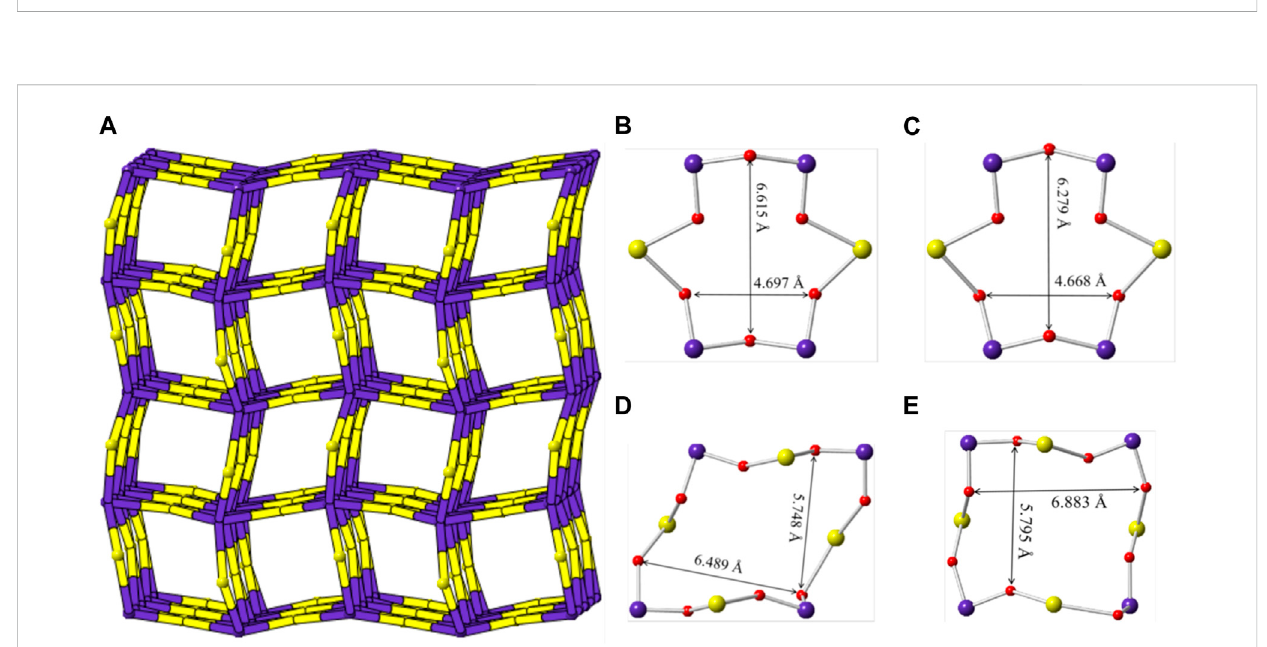
FIGURE 8 (A) View of the cation framework topology representation of Sr [(UO 2 ) (TeO 5 )] along the c -axis; (B – E) the 6-MRs and 8-MRs pore size of the [(UO 2 ) (TeO 5 )] tube along the a -, b - and c -axis. K, Te, U and O atoms are shown ain green, purple, yellow and red,